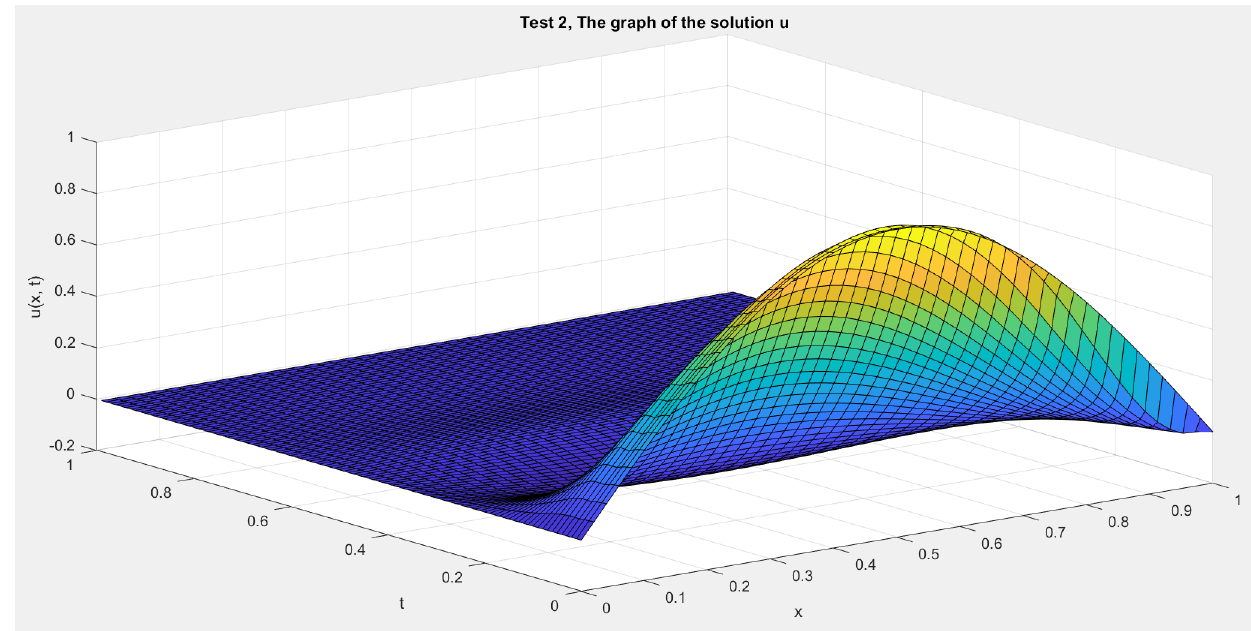
Figure 6. Test 2: The solution function u ( x , t )